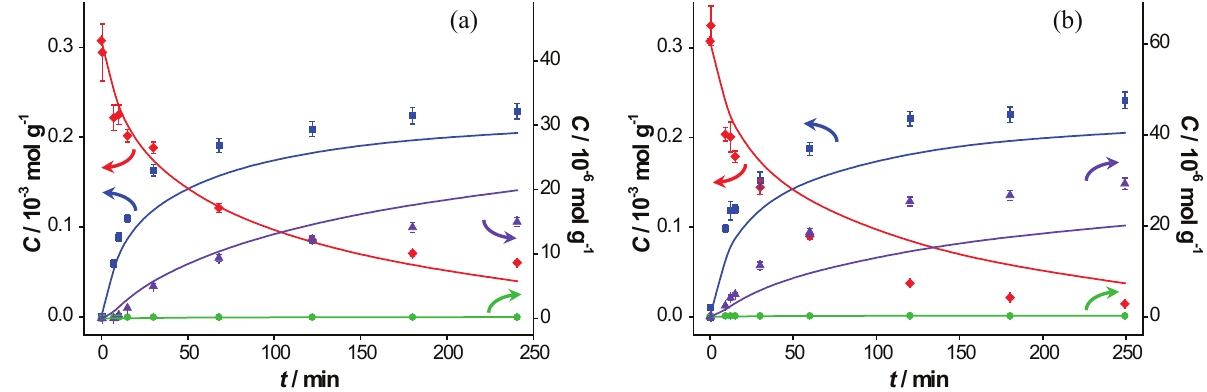
Figure 7. Catalyst performance in the presence of KF. Concentration of ( ♦ ) benzyl alcohol, ( ■ ) benzaldehyde, ( ● ) benzoic acid and ( ▲ ) benzyl benzoate vs. reaction time for catalytic reaction over fresh AUROlite ™ in the presence of KF. ( a ) First run using fresh AUROlite ™ and 2.1 g KF ( b ) second run using spent AUROlite ™ and ~3 g KF. Reaction conditions: T = 80 °C, 0.8 g AUROlite ™ , C = 3.0 × 10 − 4 mol · g − 1 , in 80 mL of toluene, BnOH, t=0 200 mL · min − 1 air flow. Concentrations are expressed in moles per unit mass of liquid in the reactor (mol · g − 1 ). The symbols with error bars are the experimental results and the lines represent the kinetic